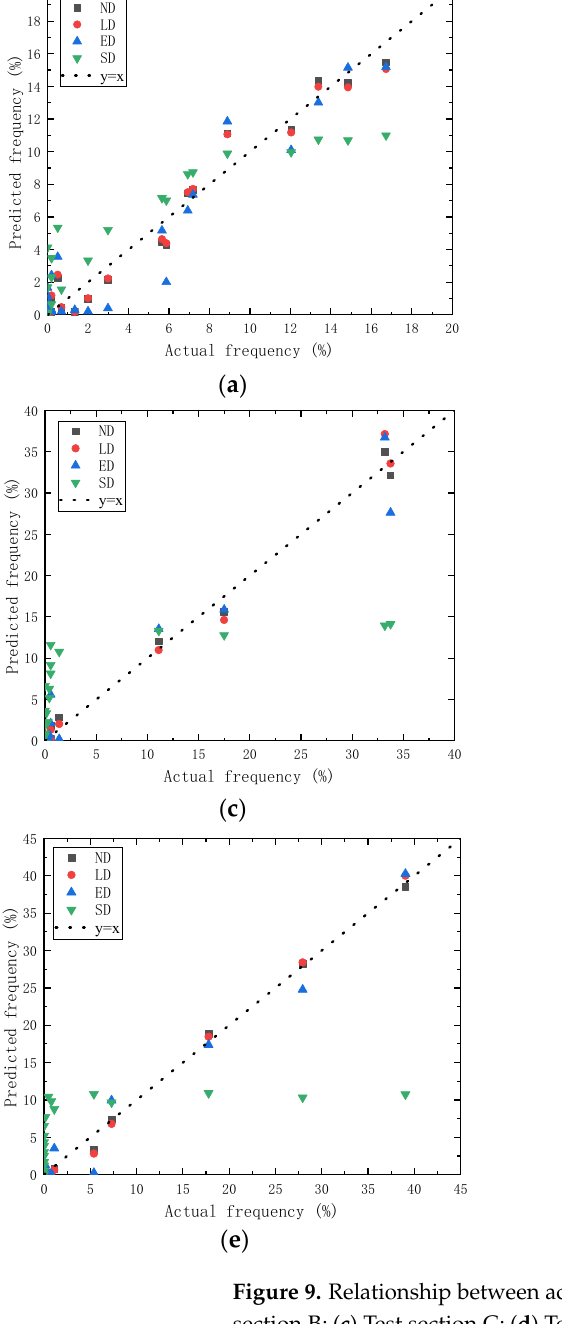
Figure 10. Sum of squares of errors for different probability distribution models. 3.4. Determination of Compaction Degree Detection ‐ Spacing In order to improve the detection efficiency, the detection spacing is required to be as long as possible. This might lead to a cost of a reduction in accuracy and representa ‐ tiveness. An appropriate detection spacing that balances the above ‐ mentioned two as ‐ pects needs to be determined. Hence, the compaction degree was tested using the PQI instrument at different spacings, namely 10 m, 20 m, 50 m and 100 m. The average value and representative value of the compaction degree measured at different detection spac ‐ ings were calculated and shown in Figure 11. The representative value is a statistical term,